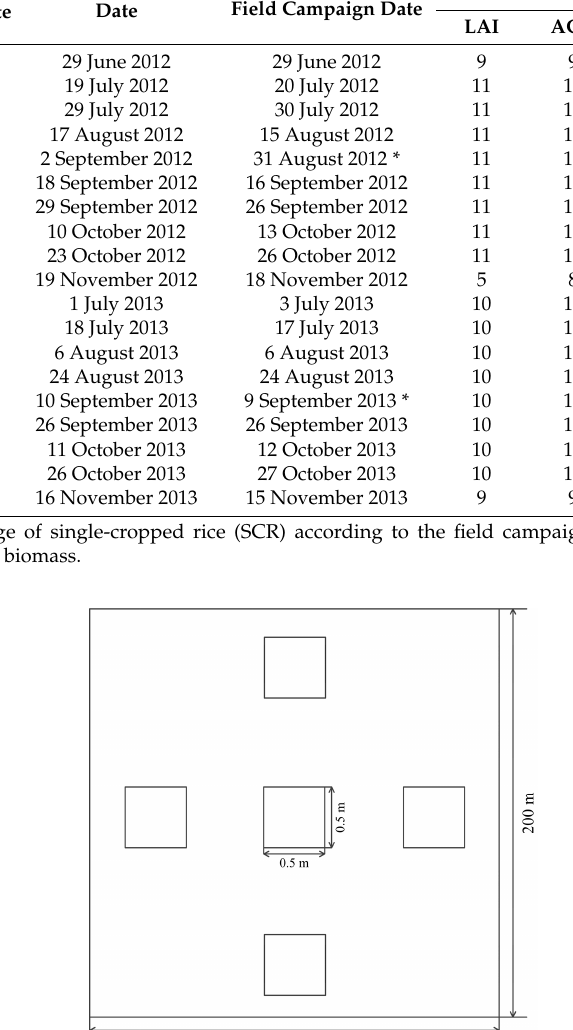
Table 1 ． Dates of the field campaigns and corresponding HJ-1A/B charge-coupled device (CCD) images with sample numbers for each date.